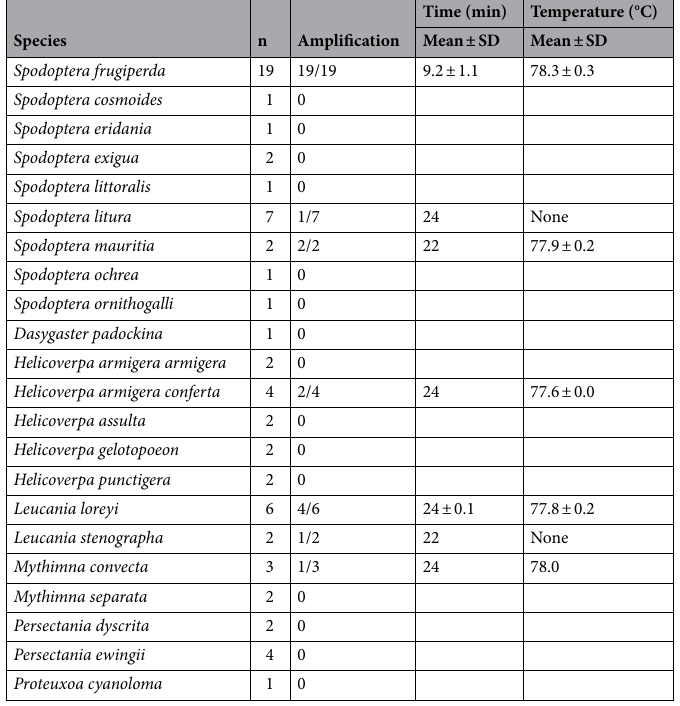
Table 3. Performance of the FAW LAMP assay using the optimised primer ratio 1:6:3.